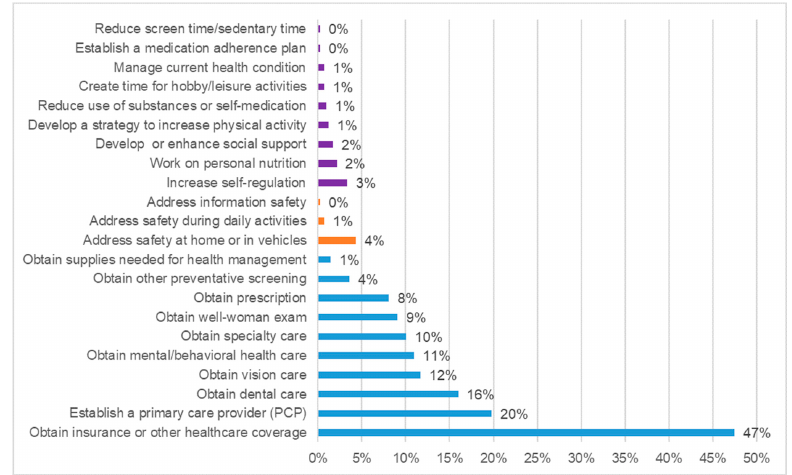
Figure 1. Proportion of health advocacy clients with selected goals by goal type ( n = 419).